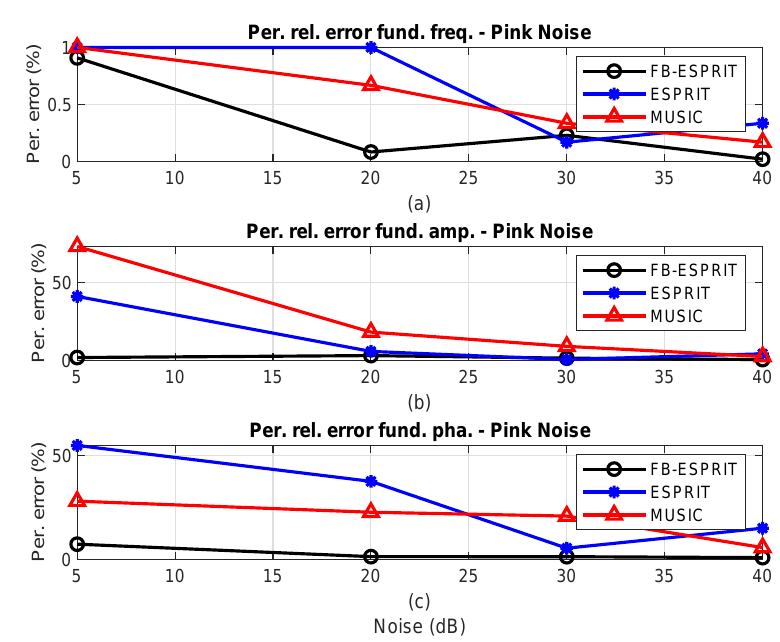
Figure 13. Percentage error (%) of the 60 Hz fundamental component when the signal s 2 ( t ) is contaminated with pink noise: ( a ) frequency parameters; ( b ) amplitude parameters; ( c ) phase